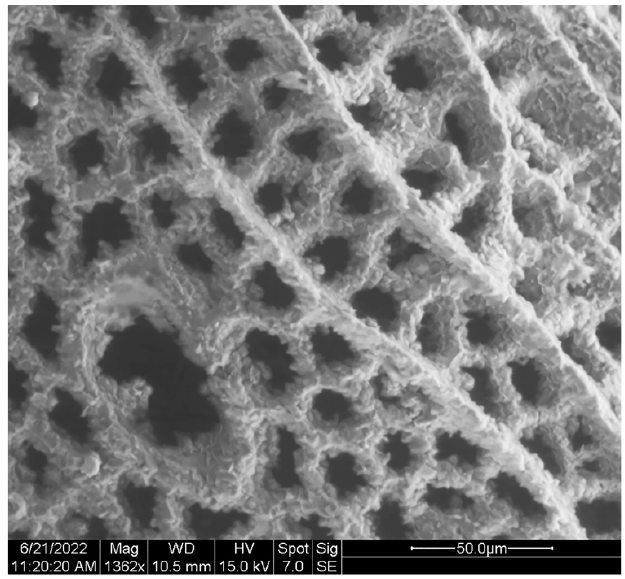
Figure 3. Kirkbya panamintensis nov. sp., detail of right valve. Holotype, IGM 5011(1). Scanning electron micrograph (secondary electrons). Crystal encrustations on the valve network are quartz crystals. Scale bar = 50 microns.